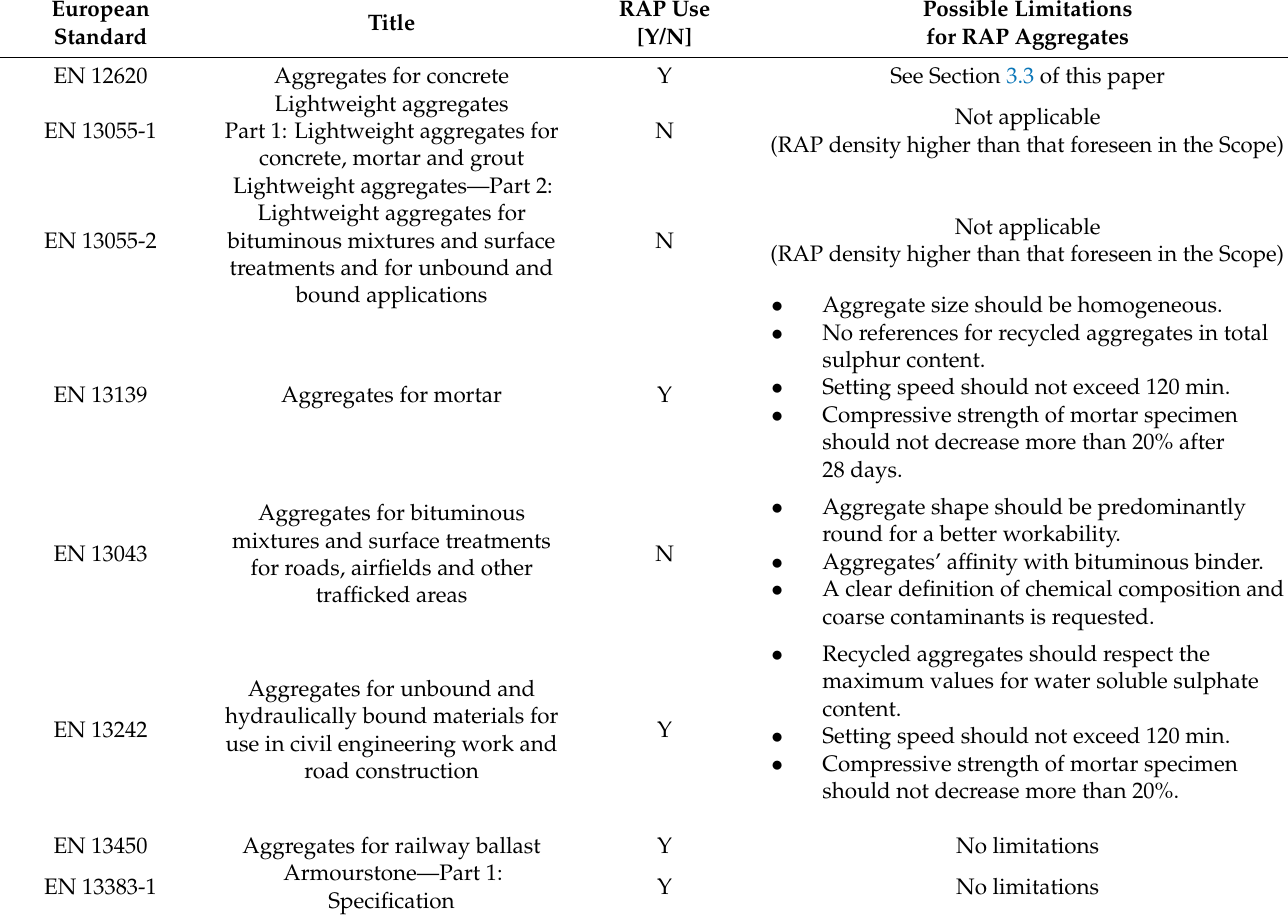
Table 3. Harmonised European standards and possible limitations for RAP